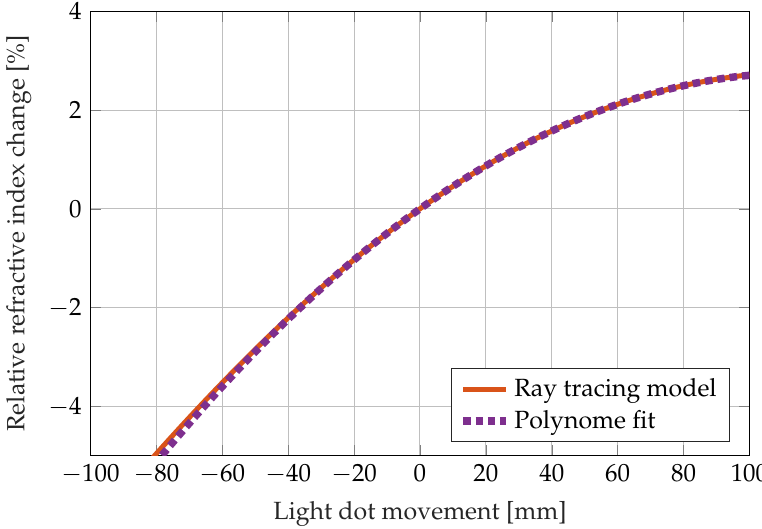
Figure 3. Relation between the visible light dot movement on the screen and the relative change of the refractive index calculated by a ray tracing model and fitted with a